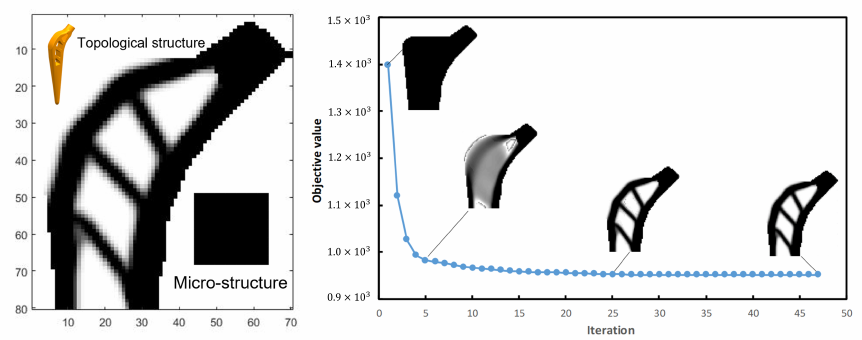
Figure 3. Topological configuration, micro-structure and solid model of A-type femoral stem.